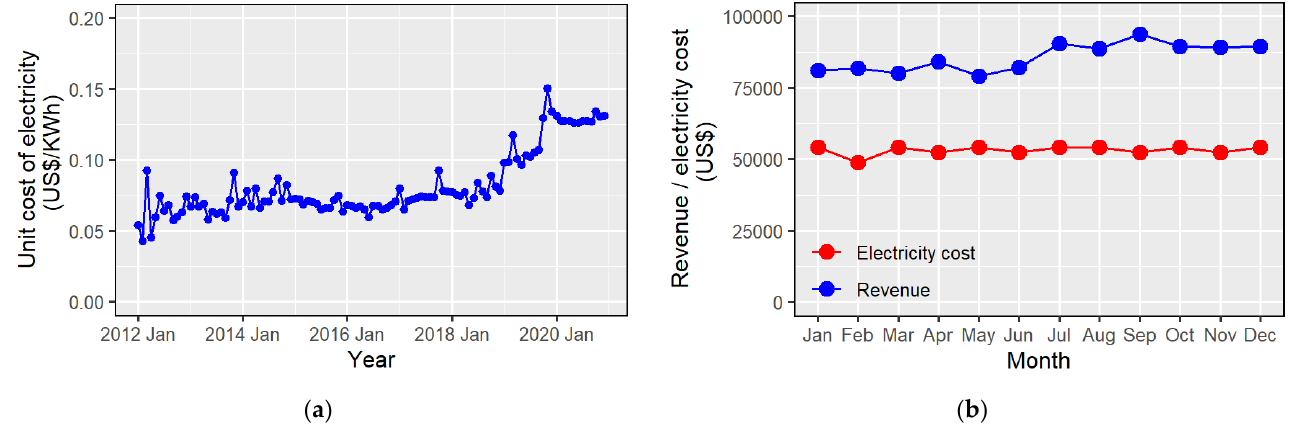
Figure 9. Electricity cost in Tajpura: ( a ) time-series of unit electricity cost; and ( b ) monthly electricity cost and revenue in